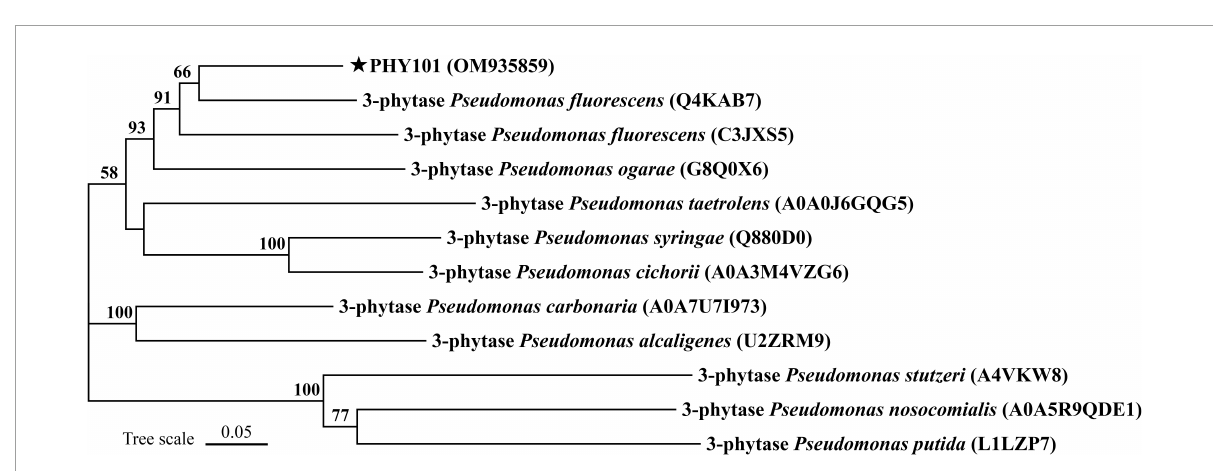
FIGURE5 Neighbor-joining phylogenetic tree of PHY101 based on sequence similarity. The numbers at the nodes indicate the levels of bootstrap support based on data for 1,000 replicates. The scale bar represents 5% sequence